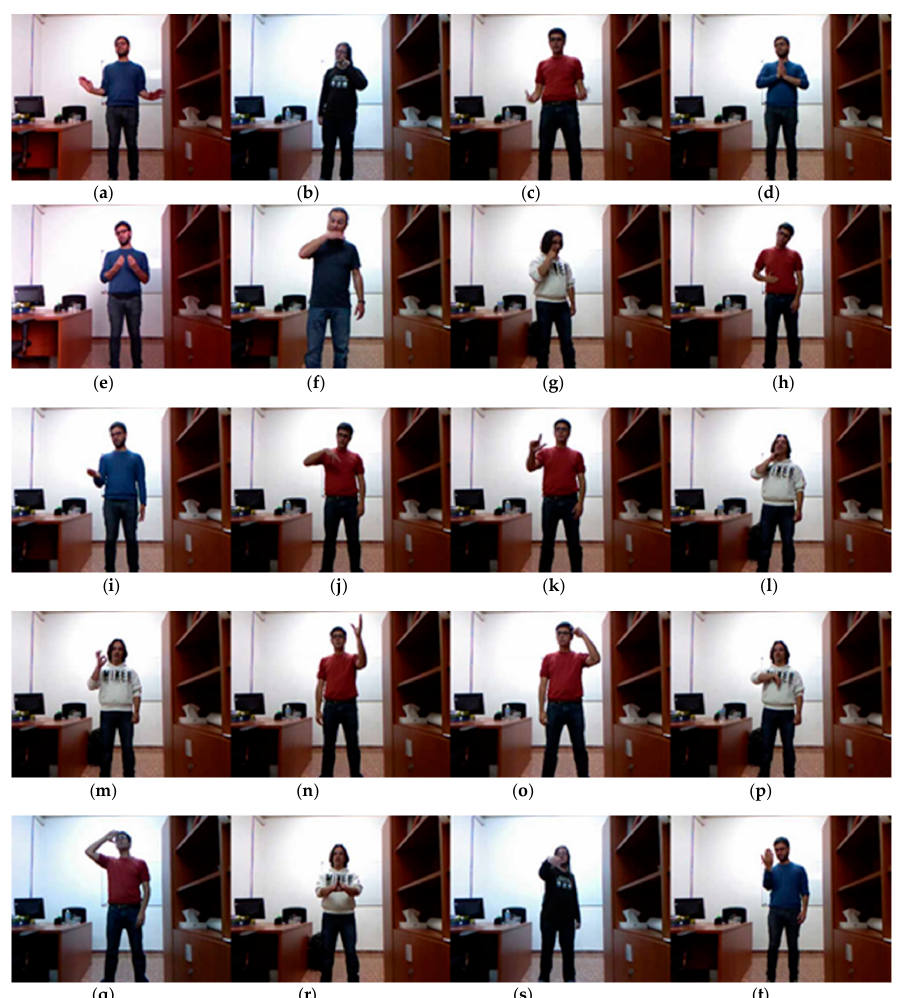
Figure 3. Italian illustrator gestures and their meaning (Italian/English) used for emotion elicitation: ( a ) Basta/Stop it. ( b ) Buonissimo/Really good. ( c ) Che due palle!/What a bore! ( d ) Che hai combinato?/What have you done? ( e ) Che vuoi?/What do you want? ( f ) Cosa ti farei/What I would do with you. ( g ) È un furbo/He’s an old fox. ( h ) Ho fame/I am hungry. ( i ) Le vuoi prendere?/Do you want to be beaten? ( j ) Sono messi d’accordo/They are conspired. ( k ) Non ce n’è più/There is no more. ( l ) Non me ne frega niente/I do not care. ( m ) Ok. ( n ) Perfetto/Perfect. ( o ) Sei pazzo?/Are you crazy? ( p ) Sono stufo/I am tired. ( q ) Tanto tempo fa/A long time ago. ( r ) Vanno d’accordo/They get along. ( s ) Vattene!/Go away! ( t ) Vieni qui/Come here.